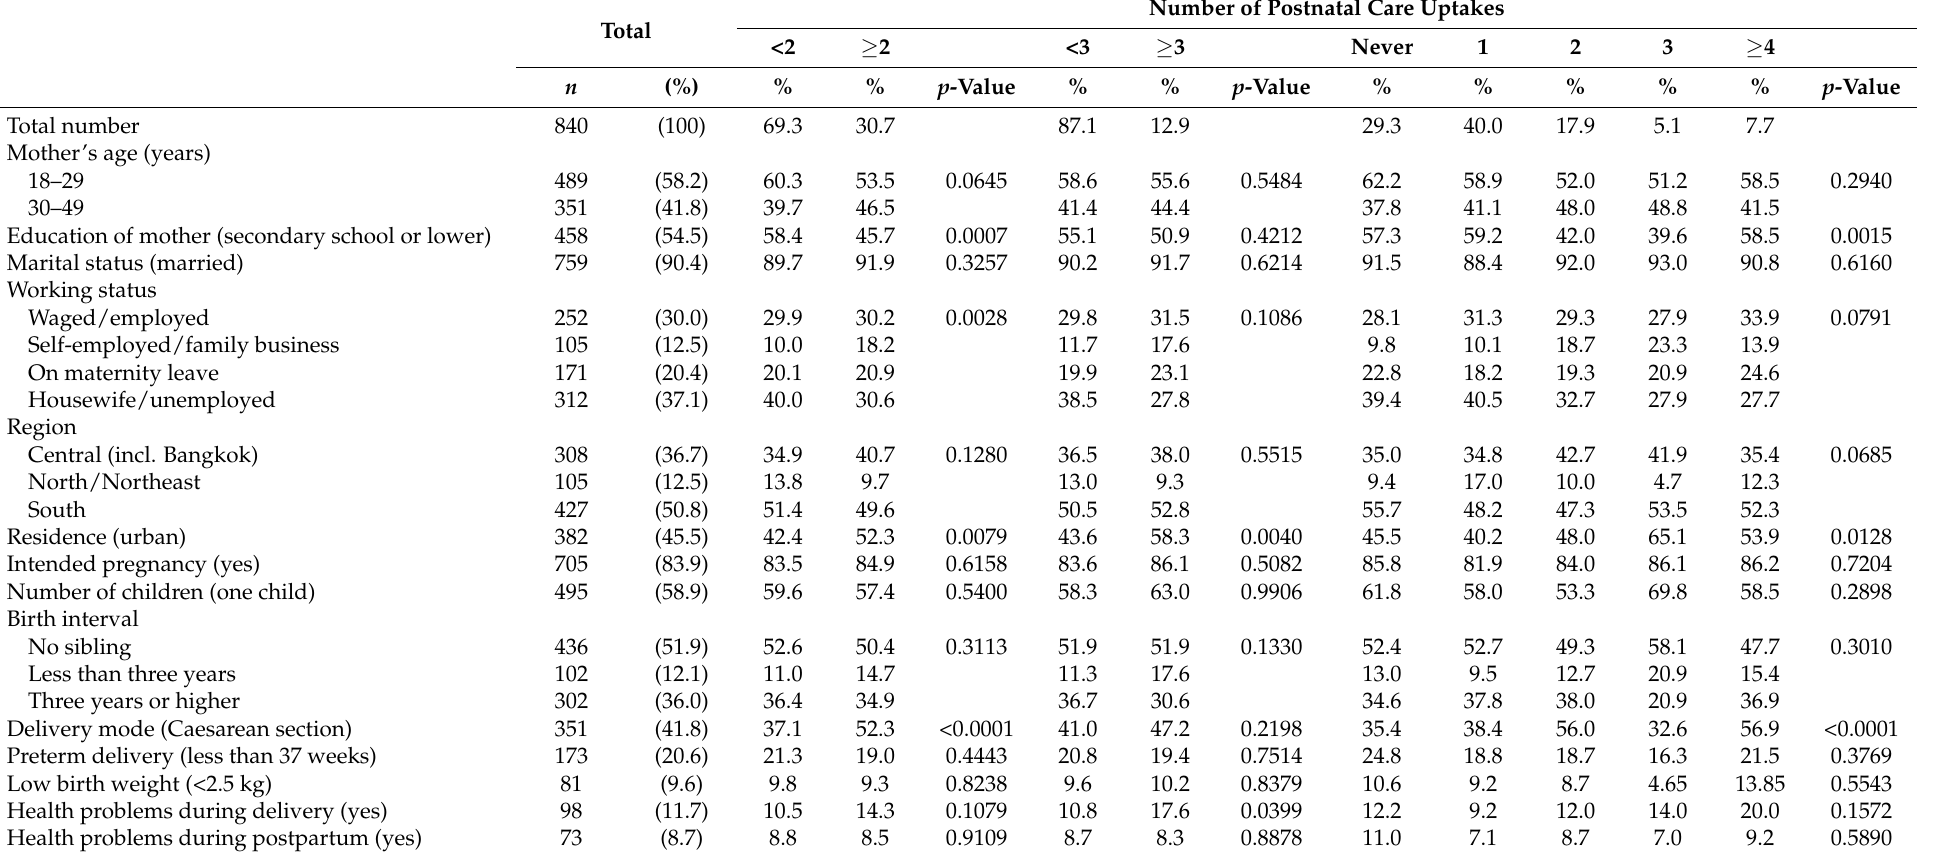
Table 1. Bivariate association between sociodemographic factors and postnatal care